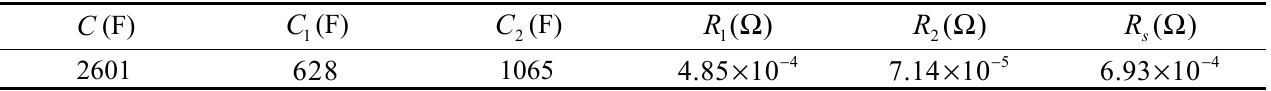
Table 2. The estimated model